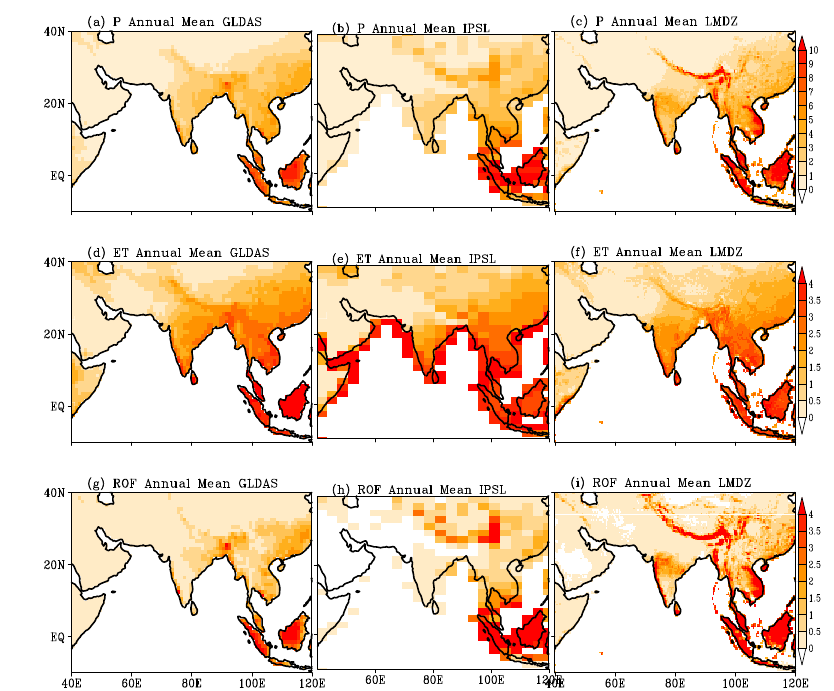
Figure 3. Spatial maps for annual mean (top) precipitation, (middle) evapotranspiration and (bottom) runoff from (a, d, g) GLDAS, (b, e, h) IPSL and (c, f, i) LMDZ simulations during 1979–2005. Units are mmd − 1 .